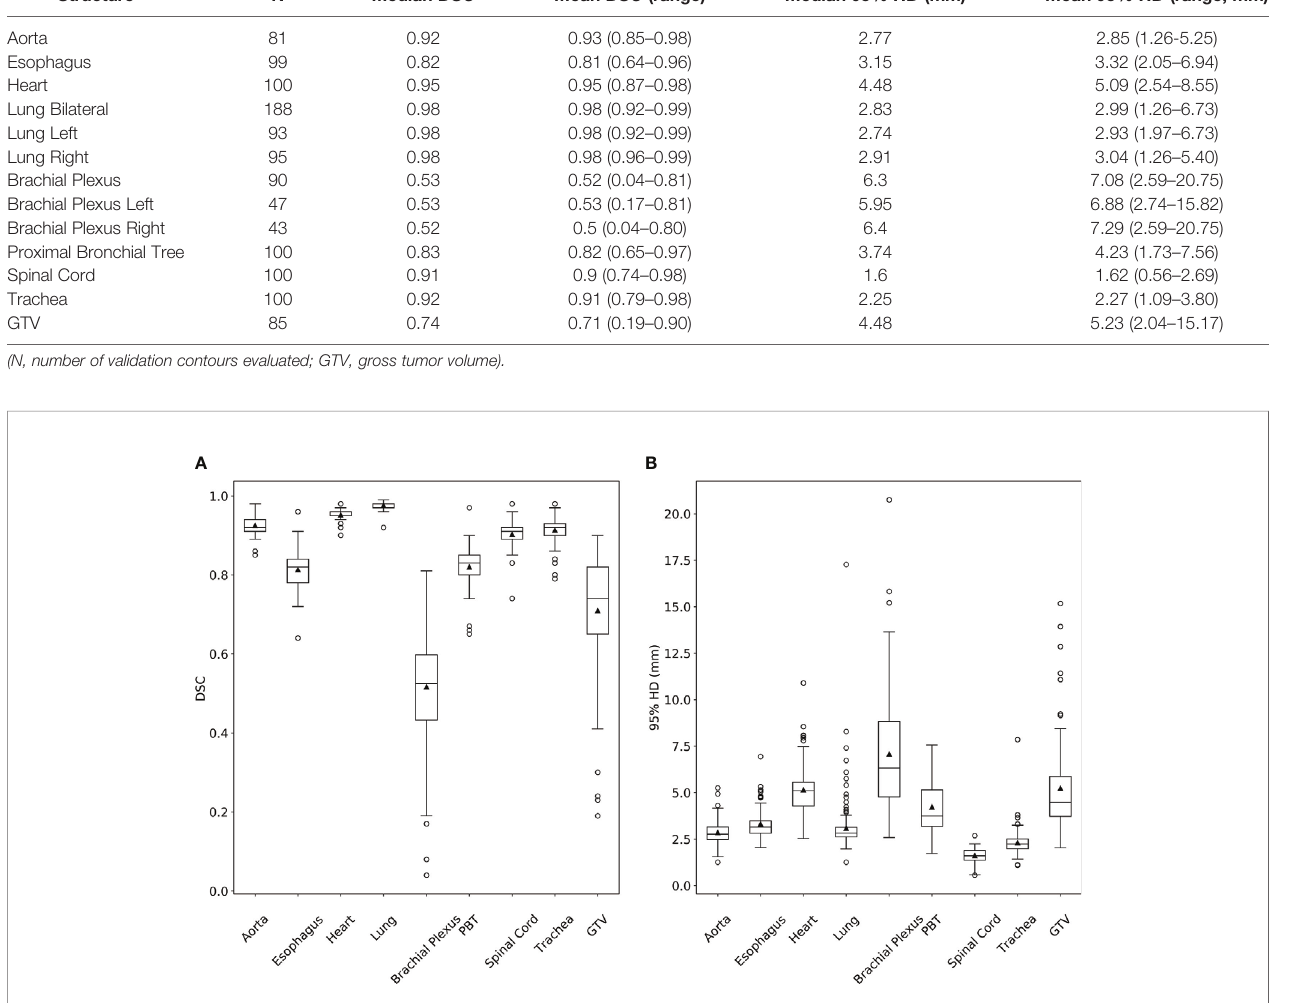
TABLE 1 | Summary of Dice Similarity Coef fi cient (DSC) and 95% Hausdorff distance (HD) metrics from comparing deep learning-based auto-segmented contours to clinical contours for lung stereotactic ablative radiotherapy planning structures. Structure